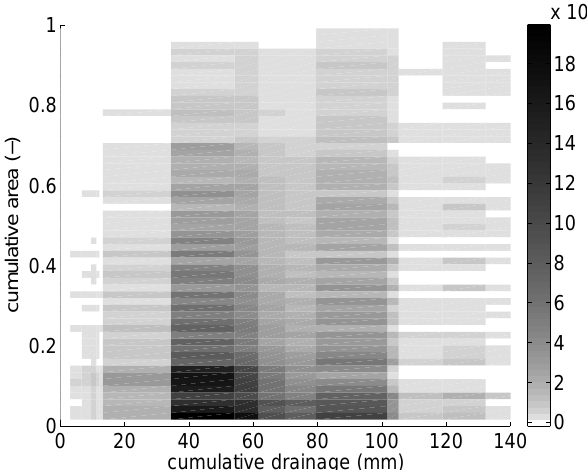
Fig. 7. Scaled solute flux density (d − 1 ) for tracer, at 0.5 m depth, for the simulated year 2010.